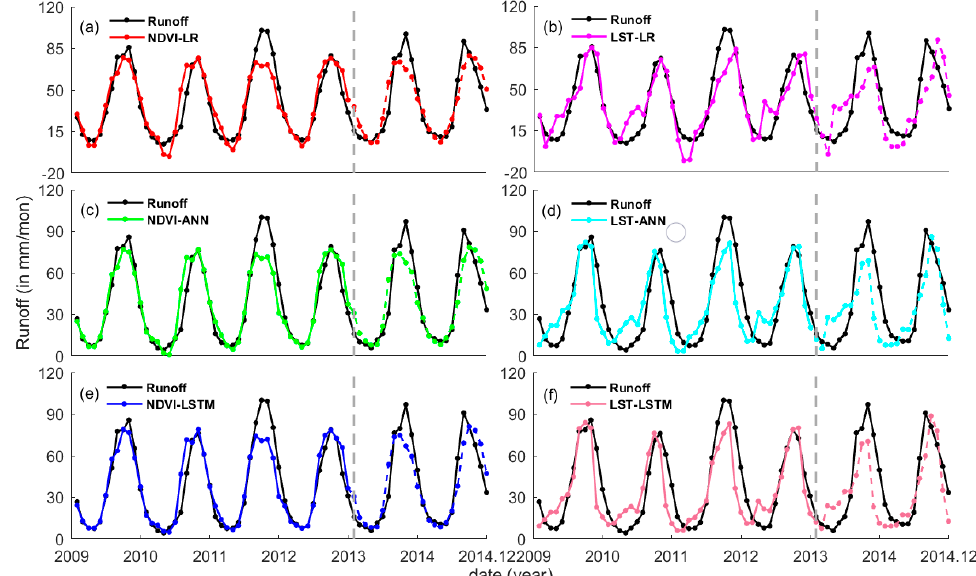
Figure 5. Reconstructed (solid line) and predicted (dash line) runoff at the TC–CD station pair based on NDVI and LST averaged over the whole upstream area from the Tibetan Plateau to the southern boundary of Cambodia via ( a , b ) linear regression (LR), ( c , d ) ANN, and ( e , f ) LSTM models. Rs reconstructed and predicted from RS WBVs over Yunnan Province manifested a comparable performance to those of the passive RS surface variables (Table 3), except R reconstructed from S with the lowest PCC value (i.e., 0.809) among RS WBVs. Nonetheless, R reconstructed and predicted from S over the whole upstream area yielded the highest PCC value (i.e., 0.966). R reconstructed and predicted P and ET over the whole upstream area were also consistently better than those over Yunnan Province. This indicated the presence of spatially